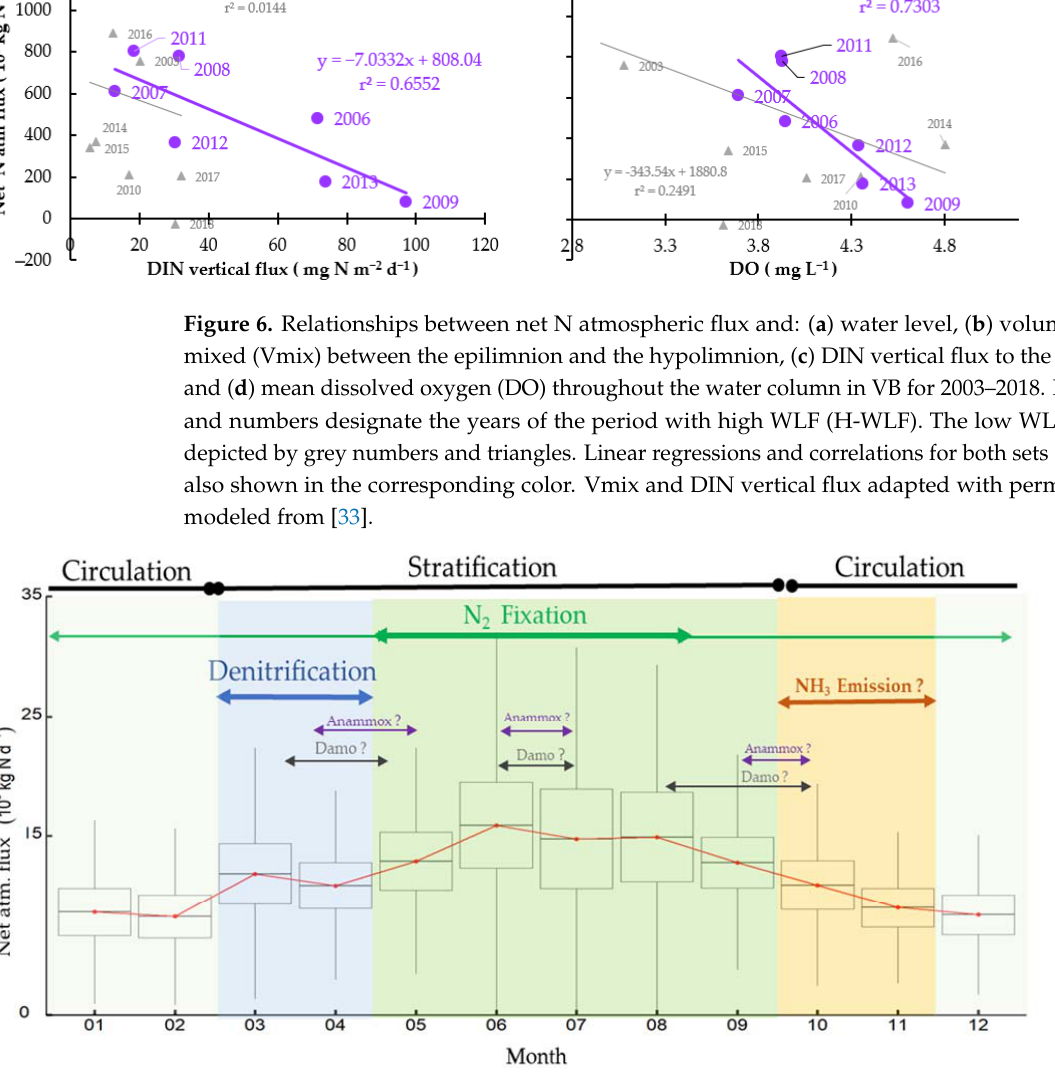
Figure 7. Mean annual evolution of the net N atmospheric flux (10 3 kg N d − 1 ) in VB during the period 2003–2018. Box plots depict SE and SD. The main N processes that affect the atmospheric flux and the proposed periods when they become more important are signaled along the annual evolution of the net N atmospheric flux and the circulation and stratification cycle of the lake (shown on top).